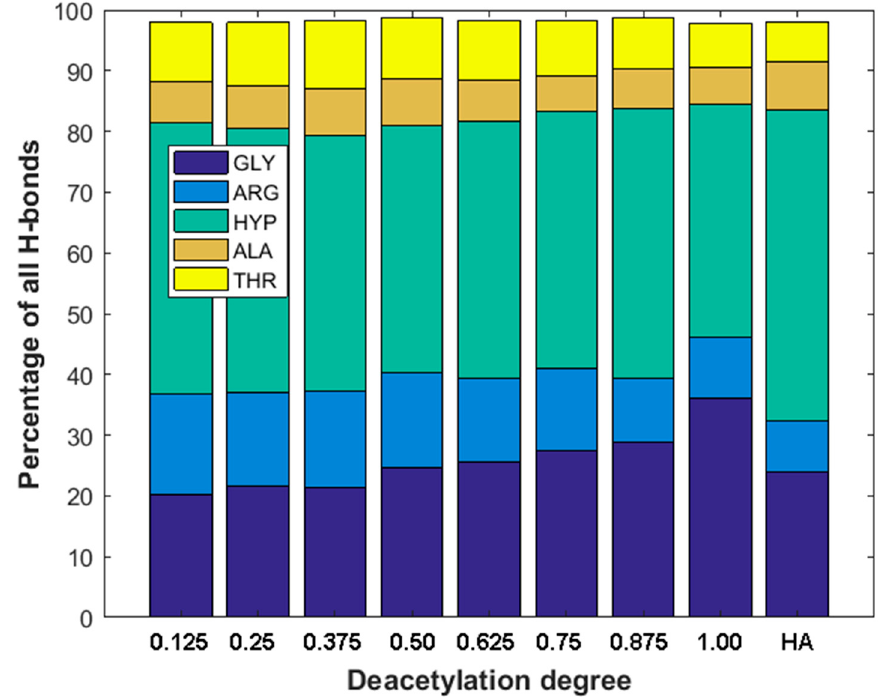
Figure 5. Distribution of H-bonds for most important amino acids vs. deacetylation degree (DD) of Chitosan and H-bonds distribution in hyaluronic acid–collagen complex (HA).